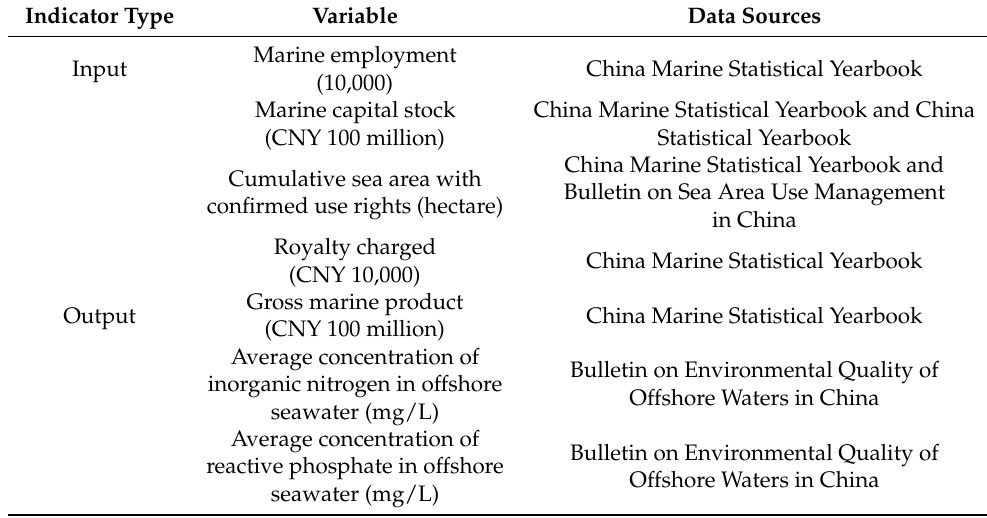
Table 1. Measurement index system of